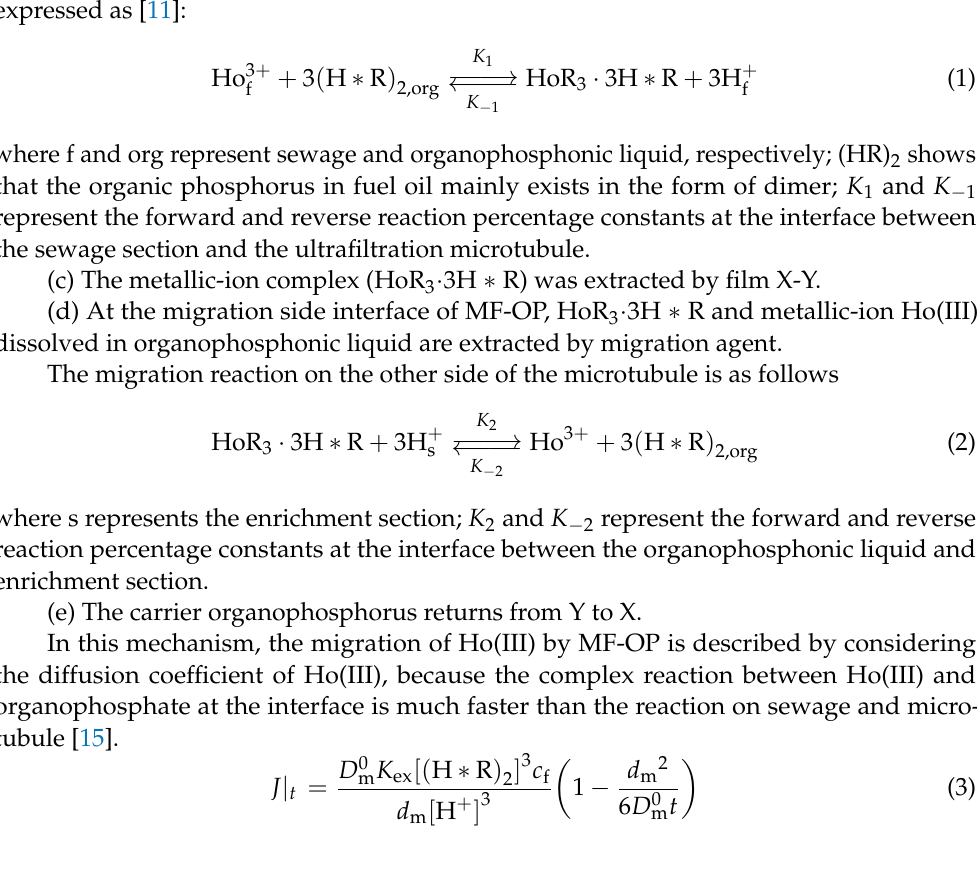
Figure 2. Diagrammatic sketch and description of Ho 3+ collection MF-OP.